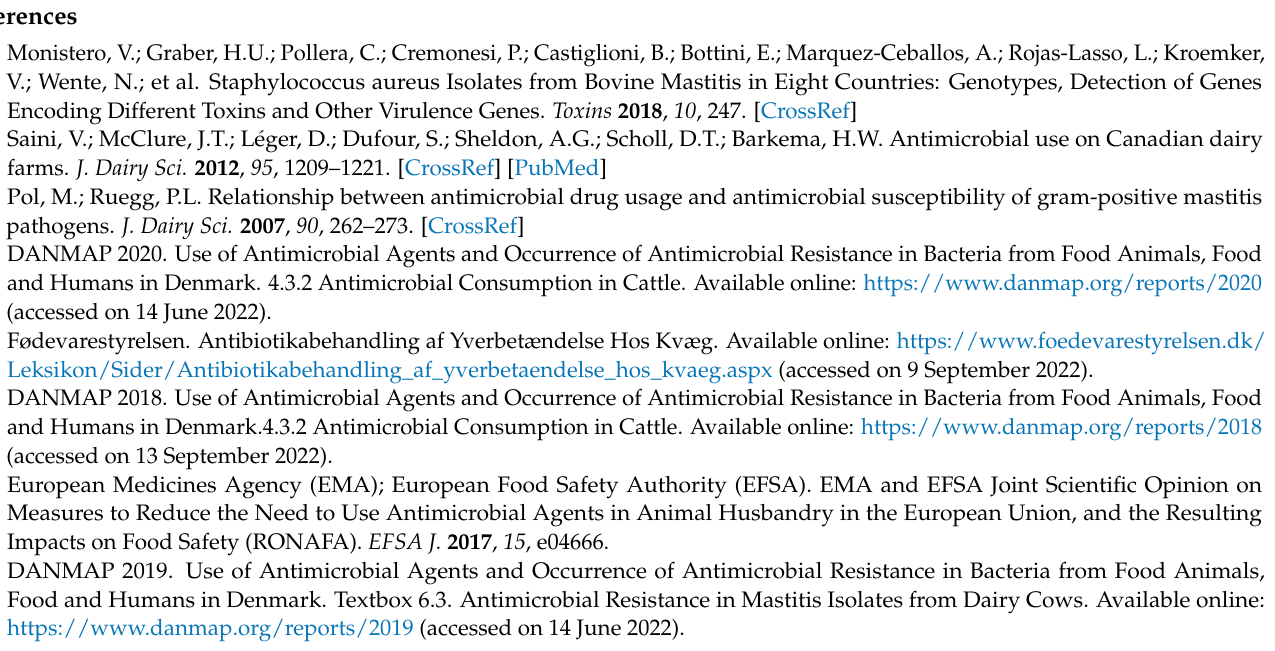
bovine clinical mastitis, Table S3: Presence of putative virulence genes in a MRSA t304/ST6 isolate from a case of